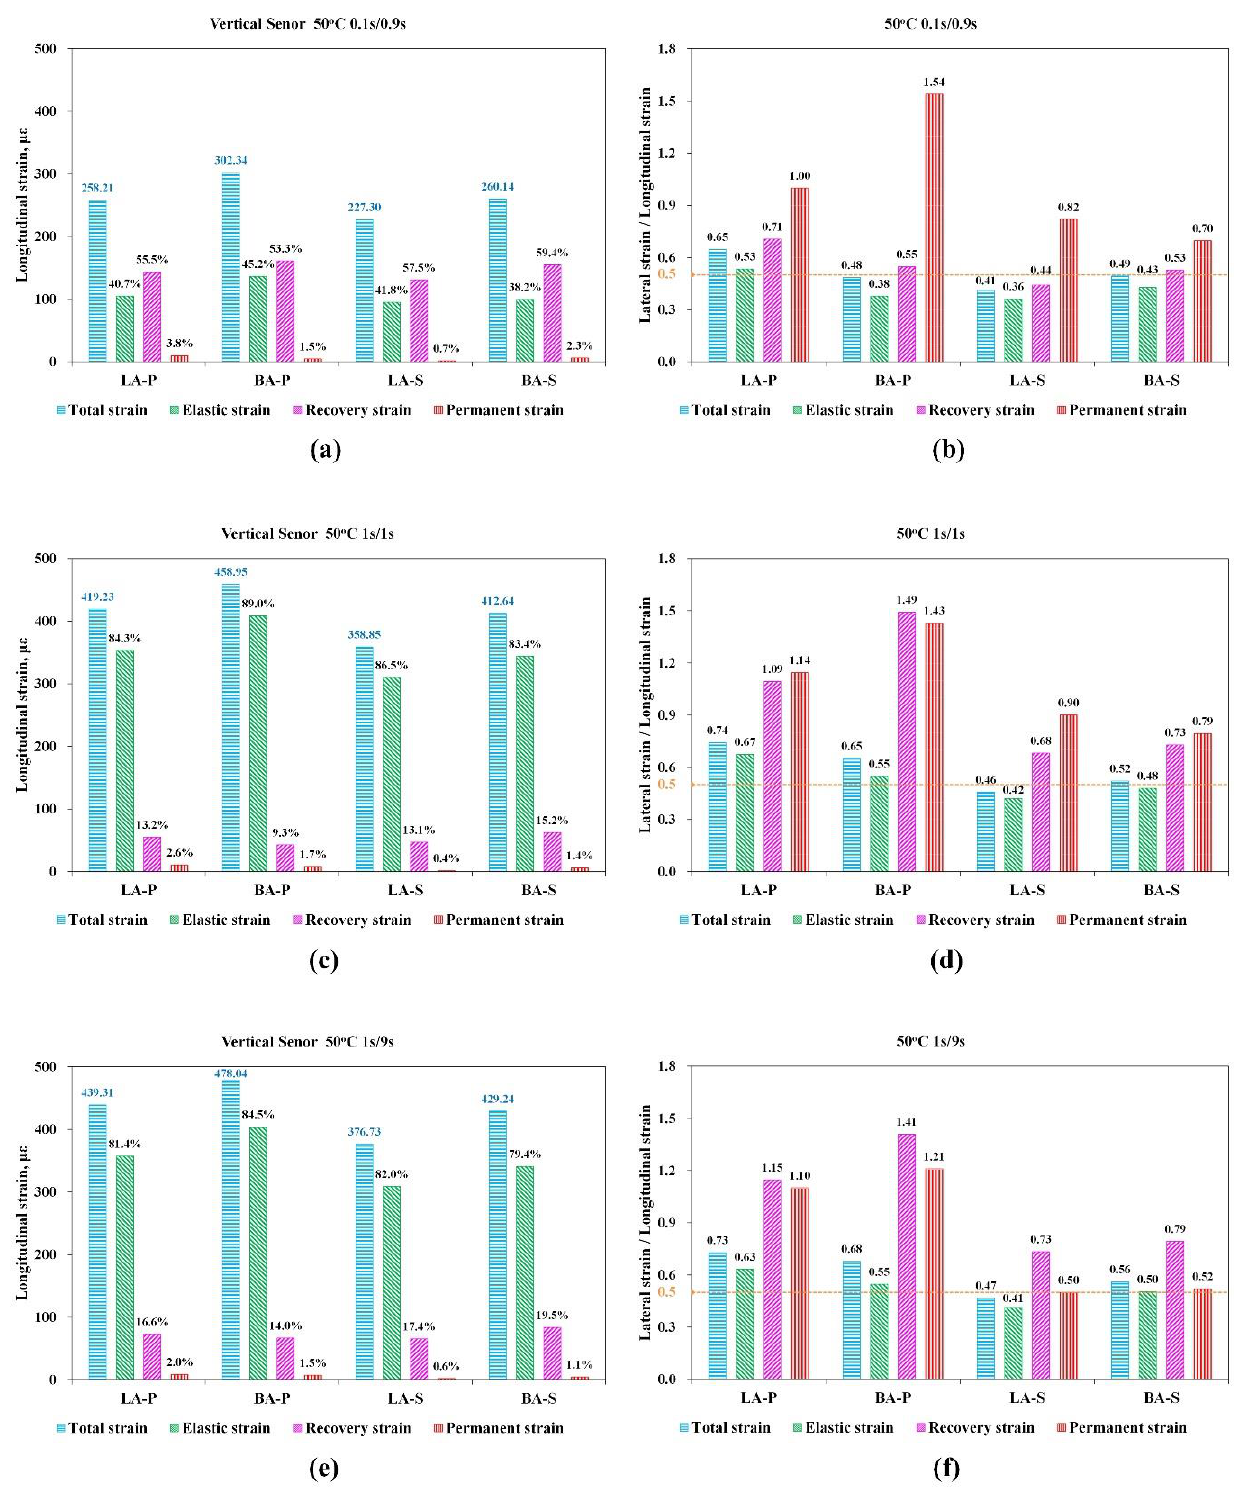
Figure 10. The longitudinal strain and the corresponding lateral/longitudinal strain ratios at the loading/rest time combinations of 0.1 s/0.9 s ( a , b ), 1 s/1 s ( c , d ), and 1 s/9 s ( e , f ) at 50 ◦ C. Strains and RLSLS at 35 ◦ Relationship between RLSLS and Permanent Strain